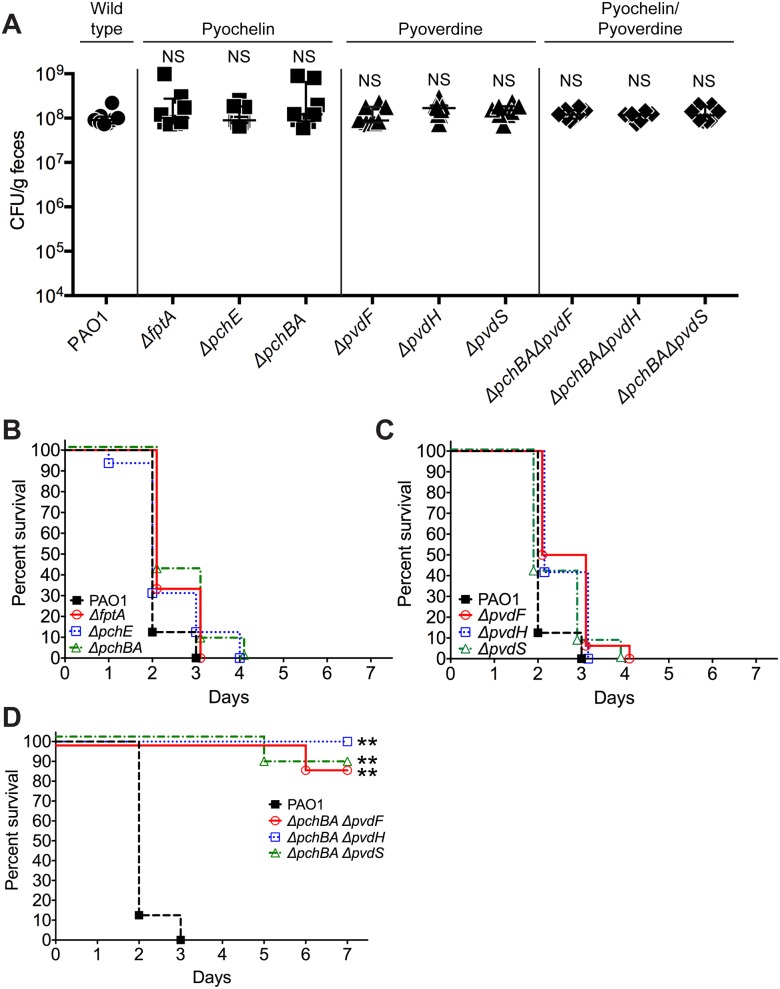
Deletion of P. aeruginosa pyochelin and pyoverdine genes attenuates P. aeruginosa virulence.
A) GI colonization levels of wild type P. aeruginosa PAO1(circles); pyochelin deletional mutants (squares; ΔfptA, ΔpchE, ΔpchBA); pyoverdine deletional mutants (triangles; ΔpvdF, ΔpvdH, ΔpvdS); and pyochelin/pyoverdine deletional mutants (diamonds; ΔpchBAΔpvdF, ΔpchBAΔpvdS, ΔpchBAΔpvdH) in C3H/HeN mice. n = 8 mice per group. Points represent results from individual animals. Horizontal lines with bars represent the median with interquartile range. Statistical analysis performed by Mann-Whitney test. * p< 0.05; ** p<0.01; ns, not significant. B, C, D) Survival curves of antibiotic-treated neutropenic C3H/HeN mice GI colonized with B) PAO1 pyochelin deletional mutants, C) PAO1 pyoverdine deletional mutants, and D) PAO1 pyochelin/pyoverdine deletional mutants. n = 8 mice per group. Statistical analysis performed by log-rank test. * p< 0.05; ** p<0.01; ns, not significant.